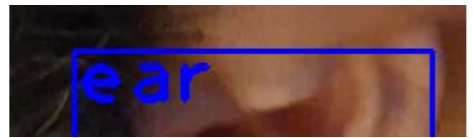
Figure 13. In some cases, YOLO detected an ear that was only partially visible within the image